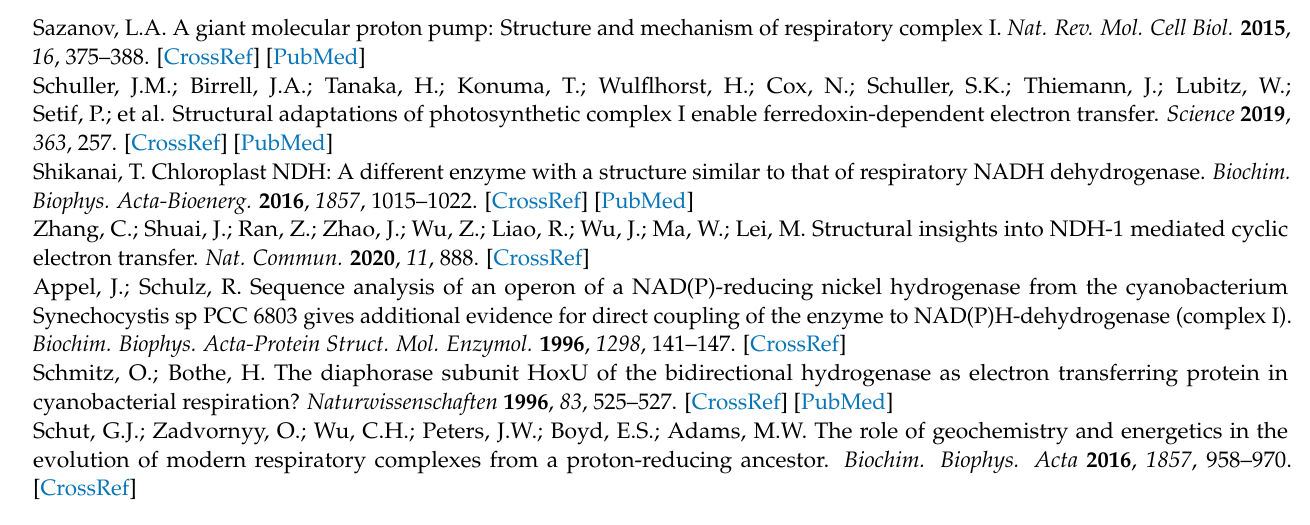
Figure S4: Hydrogenase activity as measured by the addition of 5 mM methylviologen and 10 mM dithionite to cell suspensions [14], Figure S5: Electron flow through PSI as calculated from the DIRK measurements in the absence (black symbols and curves) and presence (red symbols and lines) of hydrogen, Figure S6: Hydrogen uptake rates plotted against actual H 2 concentration, Figure S7: H 2 concentration curves in equilibrium with a specific Fd red /Fd ox ratio plotted against pH, Figure S8: Electron flow through PSI as measured by DIRK before (green) and after (red) glucose addition, Figure S9: Distribution of Hox and NDH-1 in Synechocystis wild type cells grown photoautotrophically at 30 µ mole photons m − 2 s − 1 and following anoxia, Figure S10: Distribution of Hox and NDH-1 in Synechocystis ∆ ndhD1 ∆ ndhD2 grown photoautotrophically at 30 µ mole photons m − 2 s − 1 and following anoxia , Figure S11: Assessment of autofluorescence in Synechocystis wild type cells grown photoautotrophically at 30 µ E/m 2 /s and following anoxia, Table S1: Primers used in this study for plasmid construction and PCR